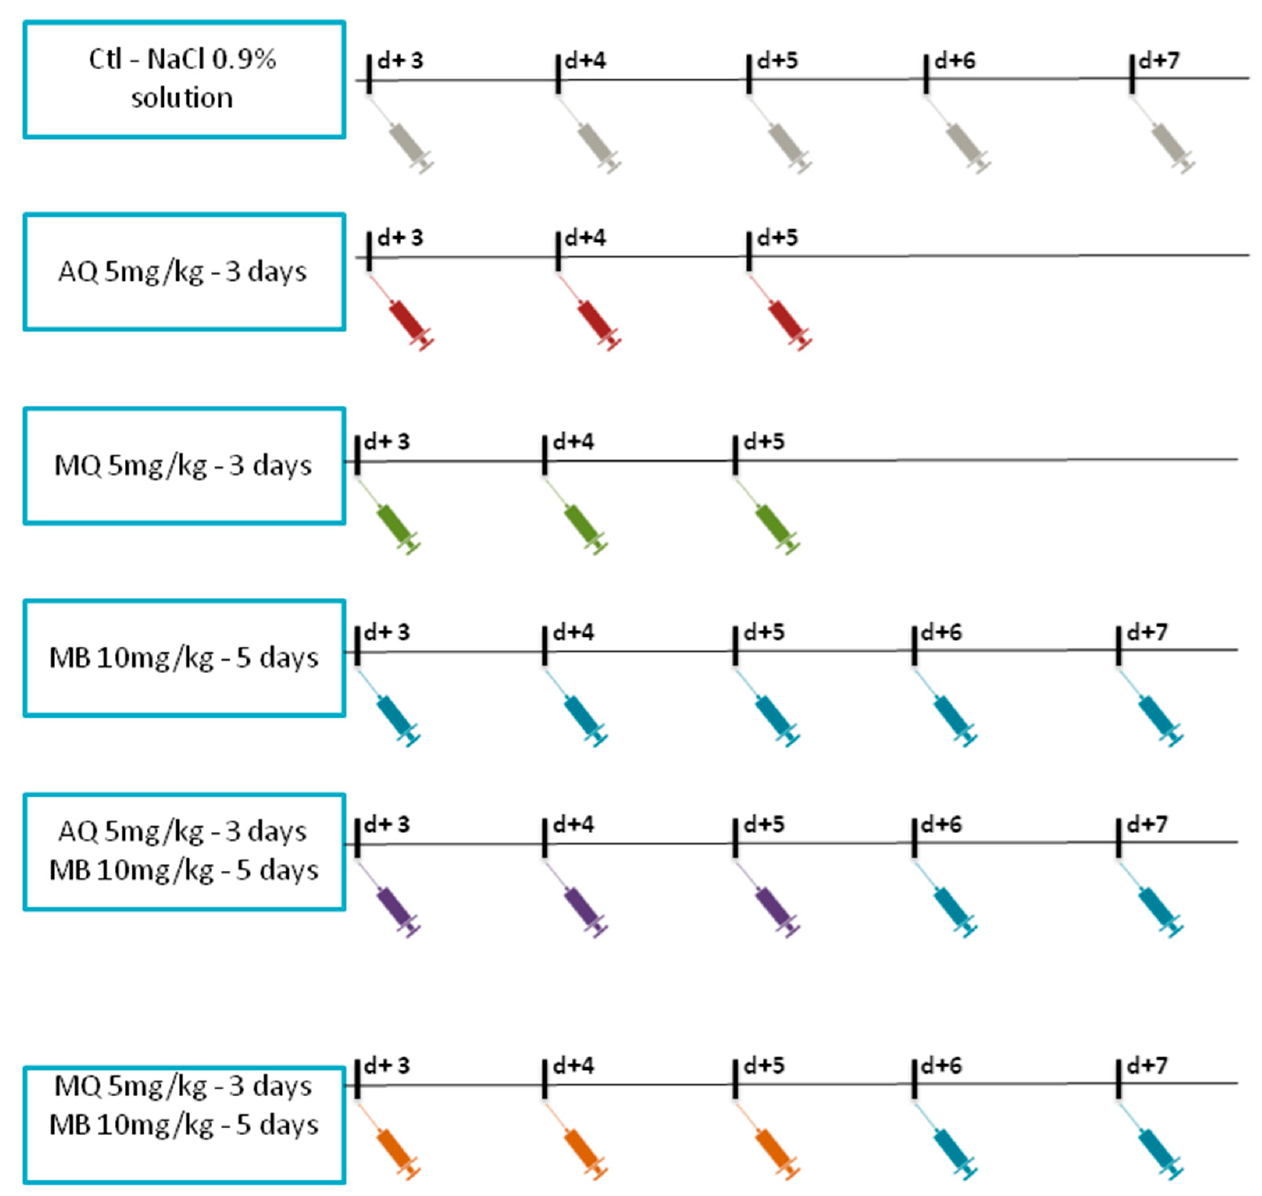
Figure 1. Schemes for malaria mice therapy. Mice were treated from D + 3 to D + 7 for CTL (vehicle), for MB 10 mg/kg alone or in combination with AQ 5 mg/kg or MQ 5 mg/kg, or from D + 3 to D + 5 for AQ 5 mg/kg or MQ 5 mg/kg alone. At D0, mice were infected with Plasmodium berghei